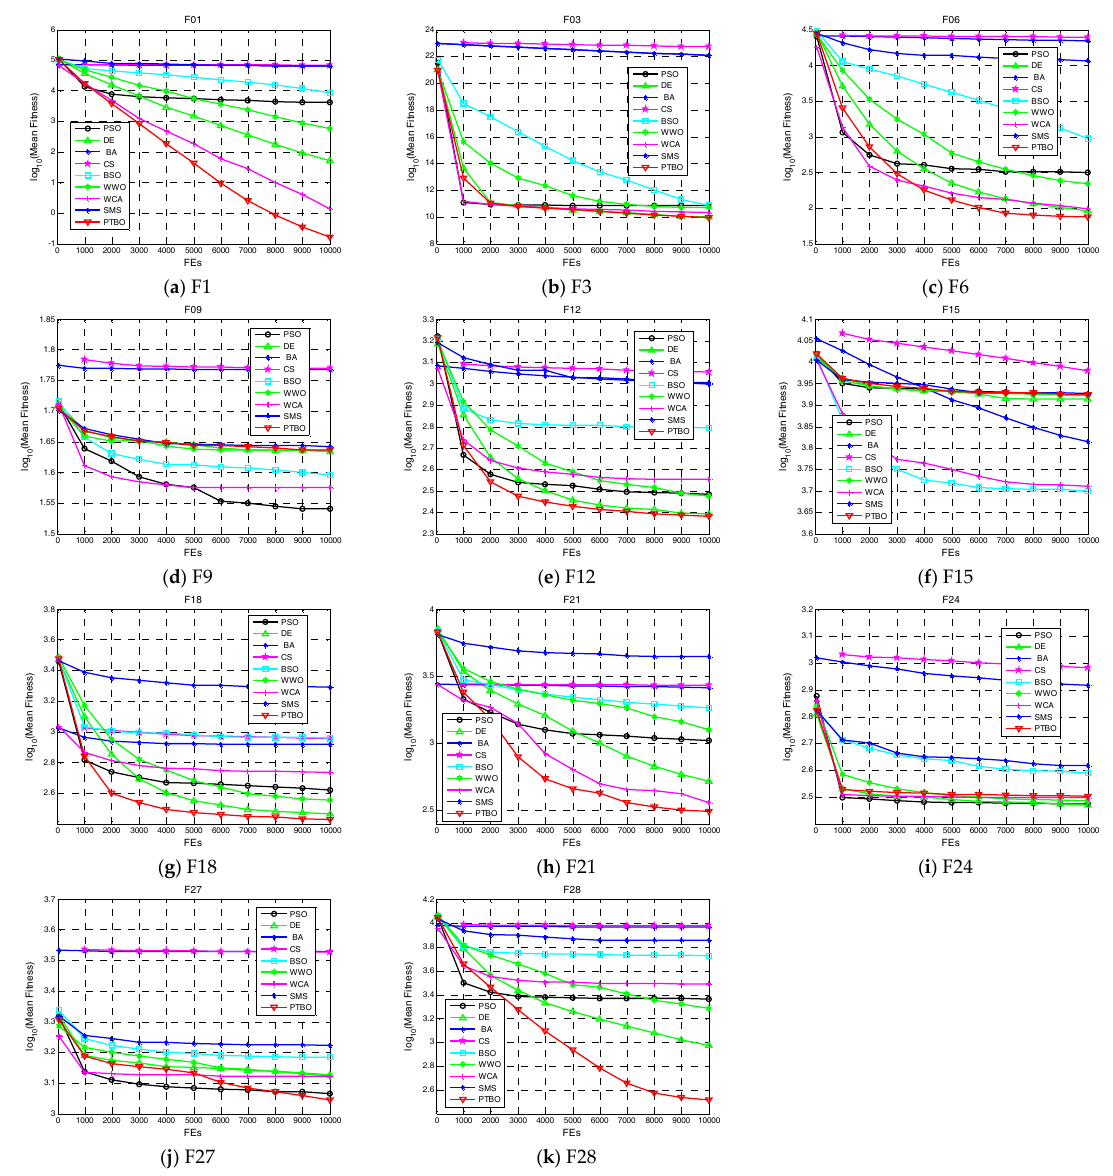
Figure 9. Convergence performance of the compared algorithms on parts of functions.